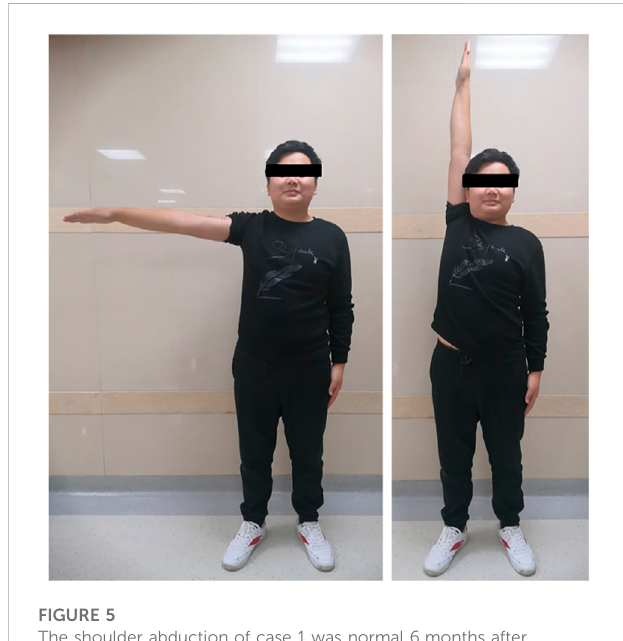
FIGURE 5 The shoulder abduction of case 1 was normal 6 months after surgery.